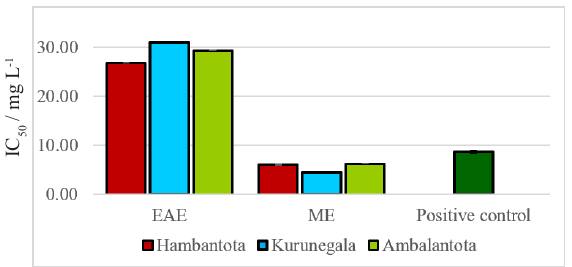
values of antioxidant 50